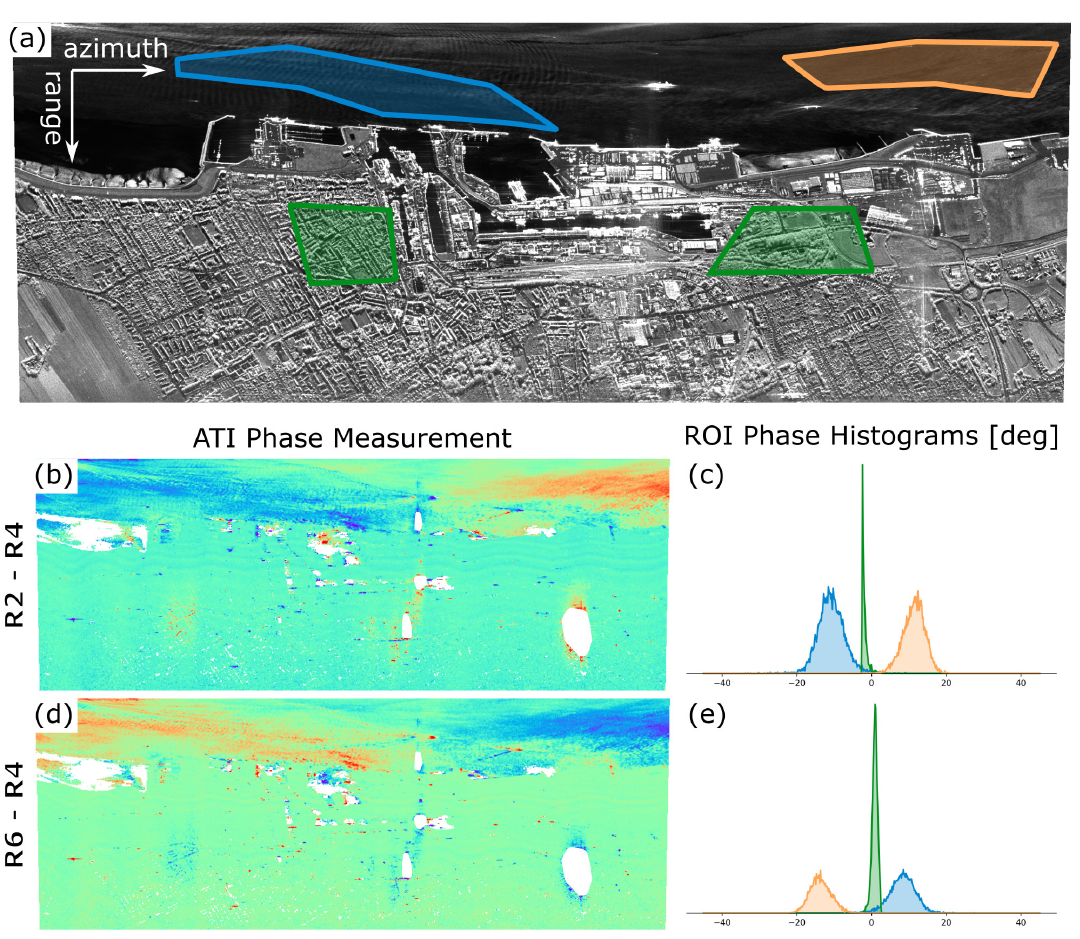
Figure 8. Along-track interferometric phase measurements of the V-SAR sensor over the city of Cuxhaven on the North Sea coast in Germany: ( a ) the backscatter amplitude at X-band, as measured in one of the six simultaneously acquired VV-pol channels, where polygons indicate regions of interest (ROIs) used for further detailed analysis; and ( b – e ) a matrix showing the along-track interferometric phase ( b , d ) and ROI phase histograms ( c , e ) for two of the five baselines. The baselines correspond to those shown in Figures 6 and